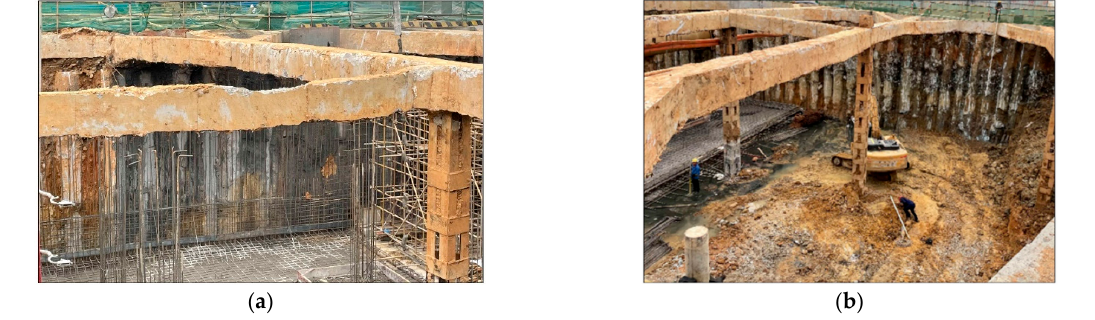
Figure 18. ( a ) Leakage of water stop curtain on the north side of the 63–68 th axis. ( b ) Water accumulation due to sudden surge of dewatering well.